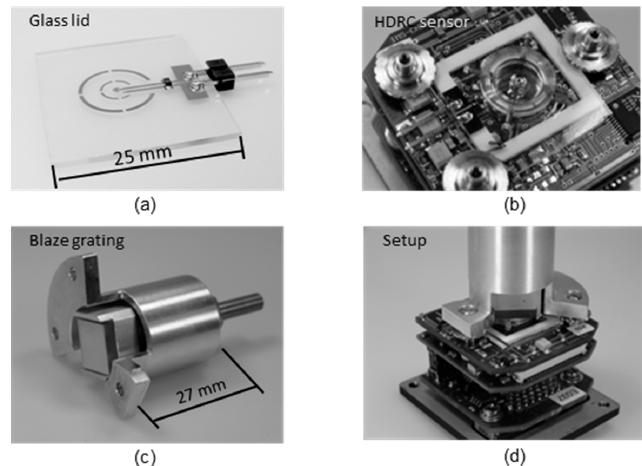
Figure 7. Demonstrator for proof of principle. ( a ) Glass lid with laser diode; ( b ) High Dynamic Range complementary metal-oxide semiconductor (CMOS) (HDRC ® ) image sensor with the glass lid and lens on top of it; ( c ) blazed grating on a rotatable shaft; ( d ) fully assembled demonstrator.